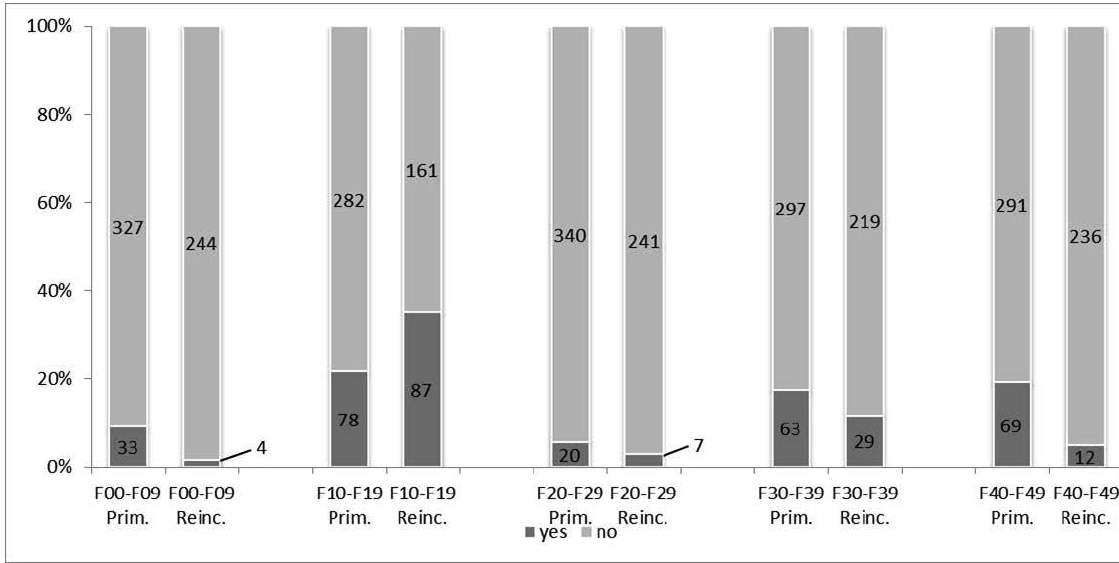
Figure 1 . Psychiatric associations to primary and recidivism for F00-F48 (ICD-10).